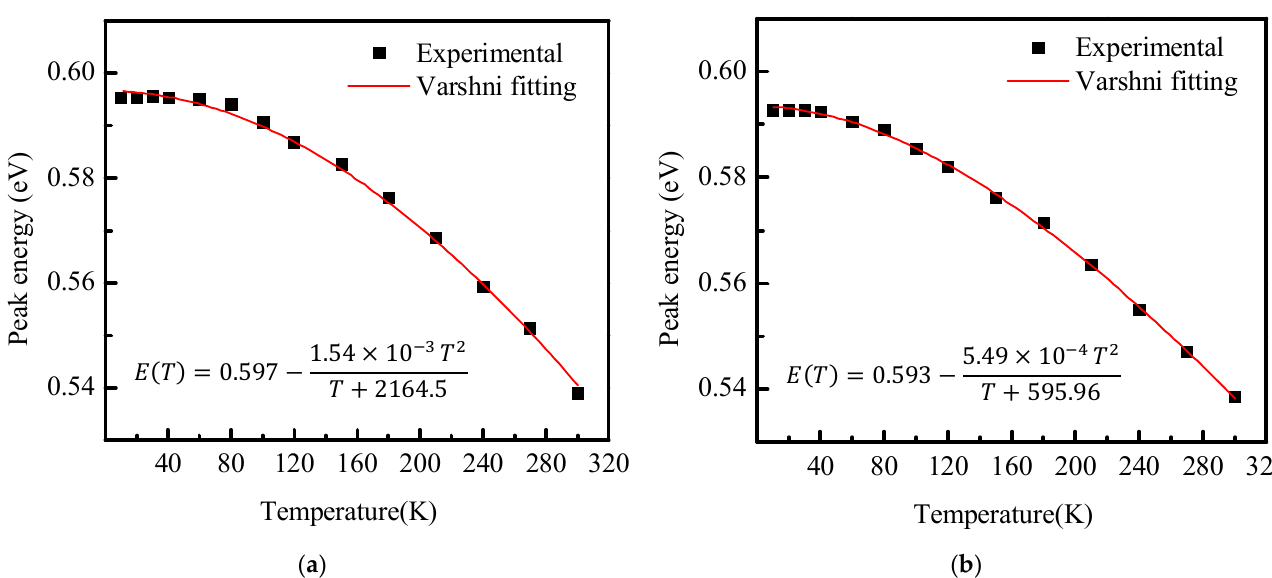
Figure 7. The peak energy of extended wavelength InGaAs on InP substrate as a function of temperature ( a ) sample A and ( b ) sample B, the fitting parameters are also given.